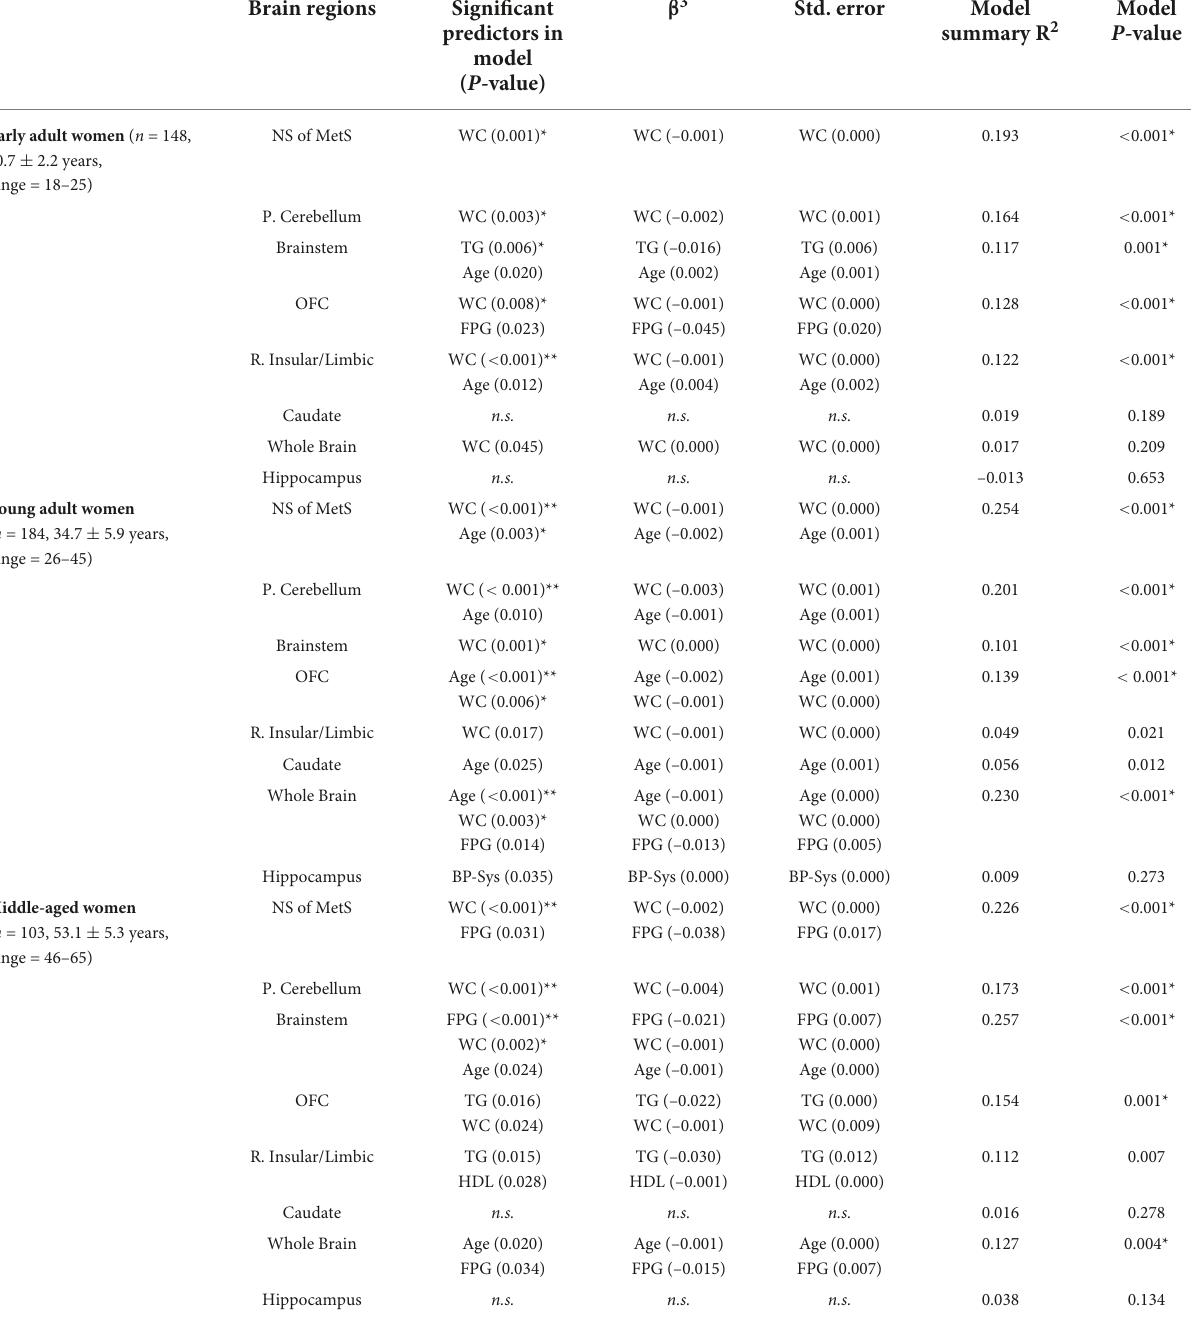
TABLE 4 MetS components’ relationship with gray matter volume in neural signature of metabolic syndrome substructures, whole brain, and hippocampus in